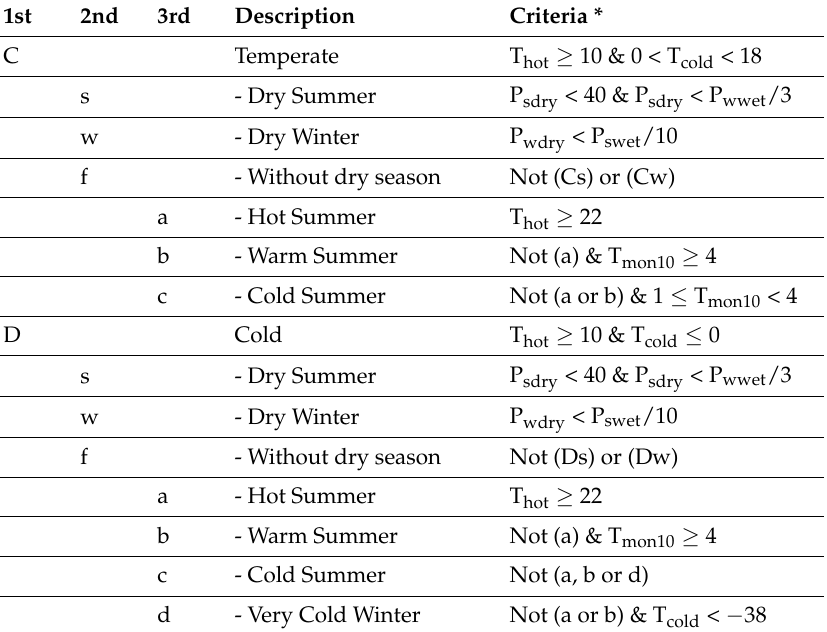
Figure 2. Map of the 575 wind turbines (black dots) in different climatic regions in Germany. Table 2. Criteria for the climatic region classification for